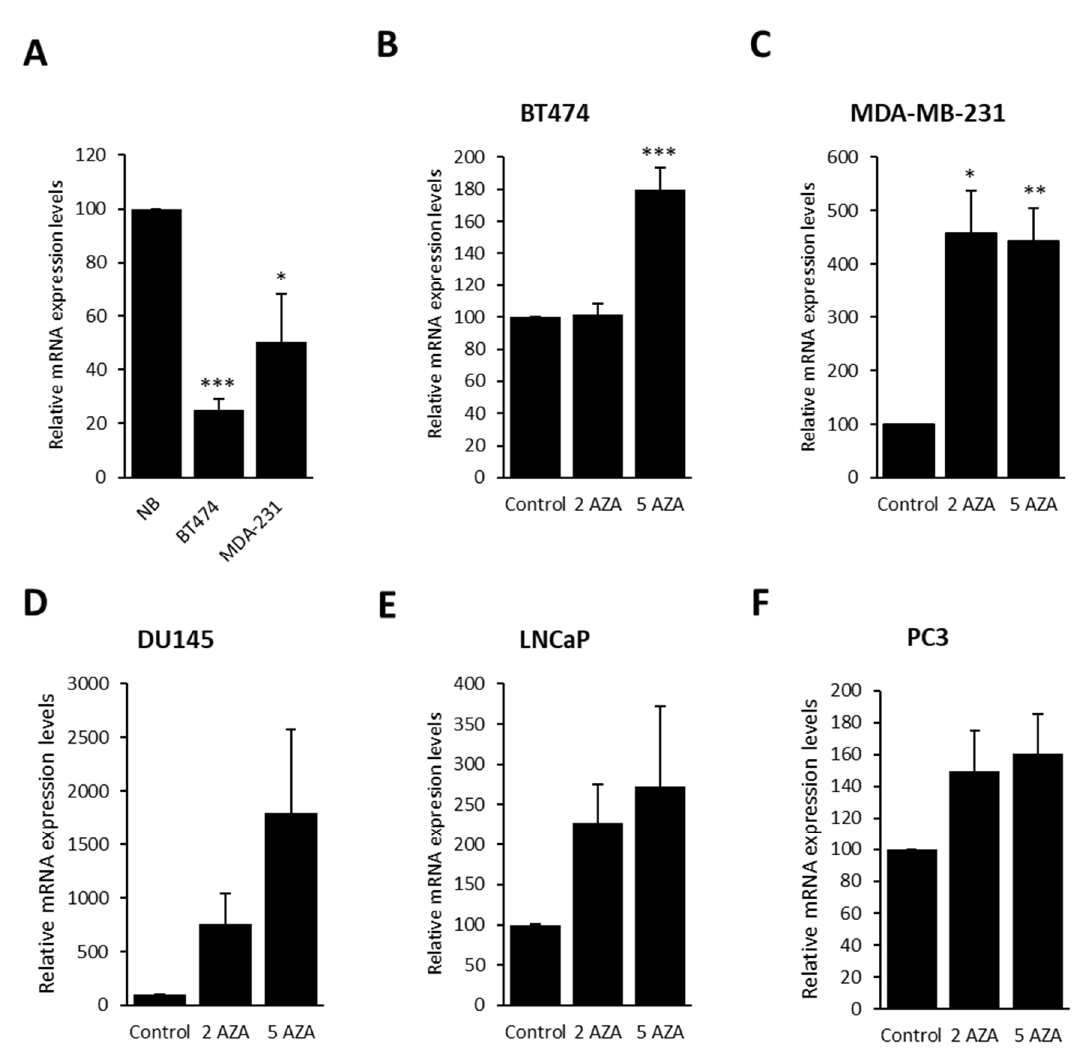
Figure 2. QRT-PCR showing the mRNA expression levels of Gfi1 in breast cancer cell lines ( A ). The treatment with 2 µ M (2 AZA) and 5 µ M (5 AZA) of t1he demethylating agent 5-aza-2-deoxycytidine reactivates Gfi1 expression in methylated cell lines ( B–F ). Data shown represent the mean ± s.e.m. of three independent experiments completed in triplicate. * p < 0.05, ** p < 0.01, *** p < 0.001.